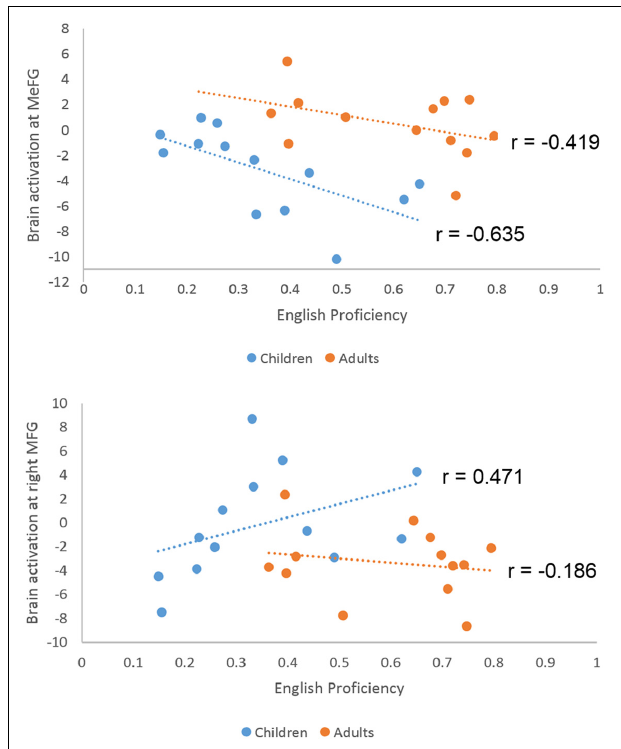
FIGURE 5 | Scatter plots for the correlation between English proficiency and brain activation level at the medial frontal gyrus and right middle frontal gyrus in children and adults. Significant negative correlation was found in children but not in adults at the medial frontal gyrus. The correlation difference between children and adults is not significant. A marginally significant positive correlation was found in the right middle frontal gyrus for